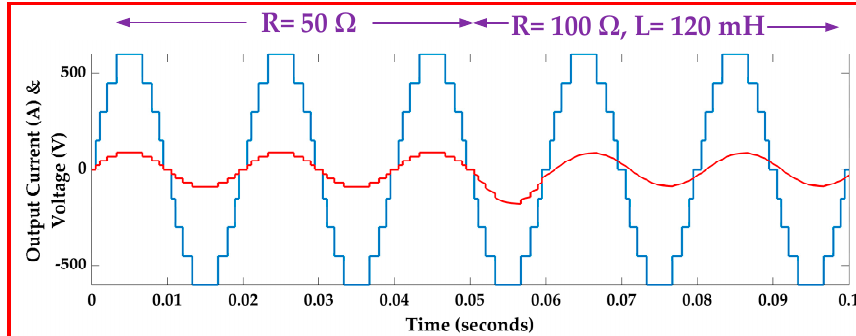
Figure 10. Dynamic resistive to inductive load change.